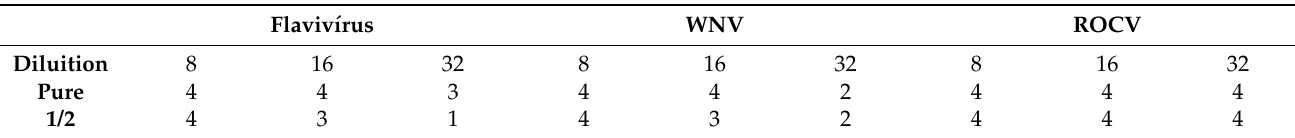
Table 3. Values referring to the degree of hemolysis of sample BeAr848804 (C6/36) in the complement fixation test